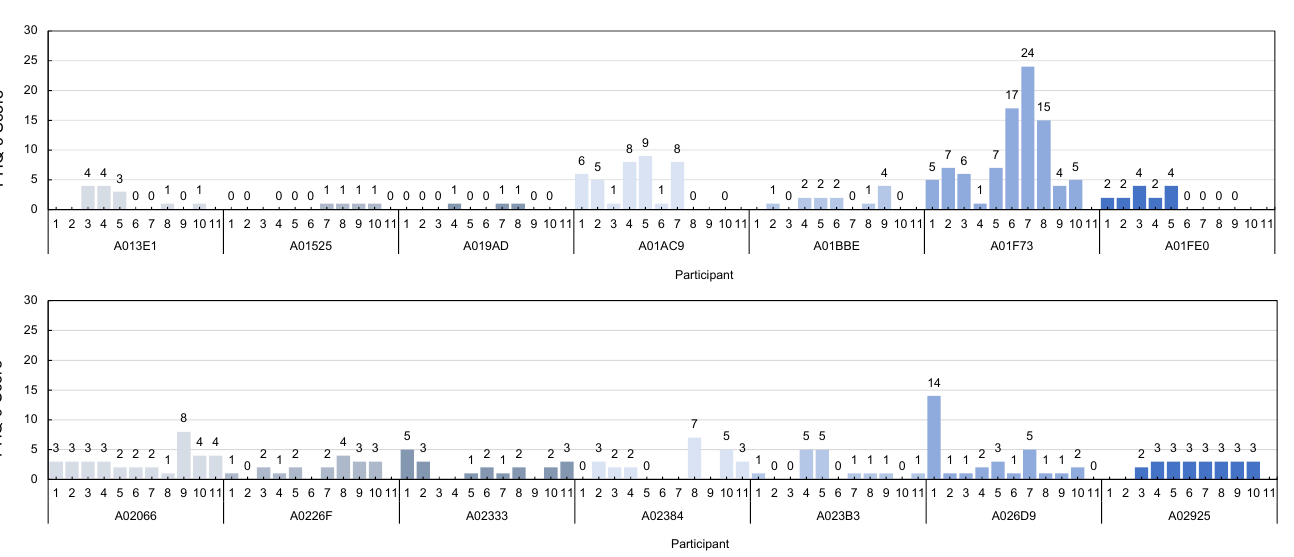
Figure 3. Results of SGDS-K Score for All Participants. PHQ-9 is performed on all the participants once a week for about 10 weeks. The survey is conducted every Wednesday and Friday. As shown in the Figure 4, the largest variation of individual weekly scores is 23 points. In this case, there is an obituary of the participant’s brother during the experiment period. When this patient conducts the PHQ-9 after the funeral, the total score is 24. This score is the highest score among all survey results. This score can be interpreted as severe depression. The person with the next greatest change has a difference of 14 points. The participant frequently mentioned concerns about his son, especially during the experiment. This participant’s highest PHQ-9 score is 14, which could be diagnosed as severe depression. The third most varied person has a 9-point difference. This participant suffers from health problems such as dental care and back pain during the experiment period.